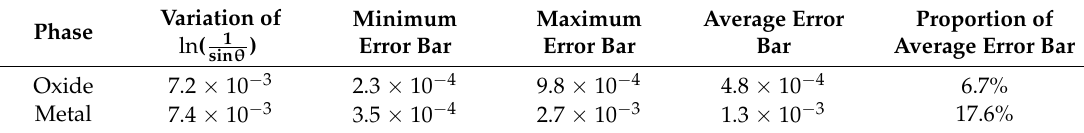
(cid:16) (cid:17) 1 Figure 11. ln versus sin 2 ψ for the metal peak (111).  versus sin  ψ for the metal peak (111). Figure 11. ln   sin θ  Table 4. Comparison of the data quality obtained from the fitting Table 4. Comparison of the data quality obtained from the fitting procedure.